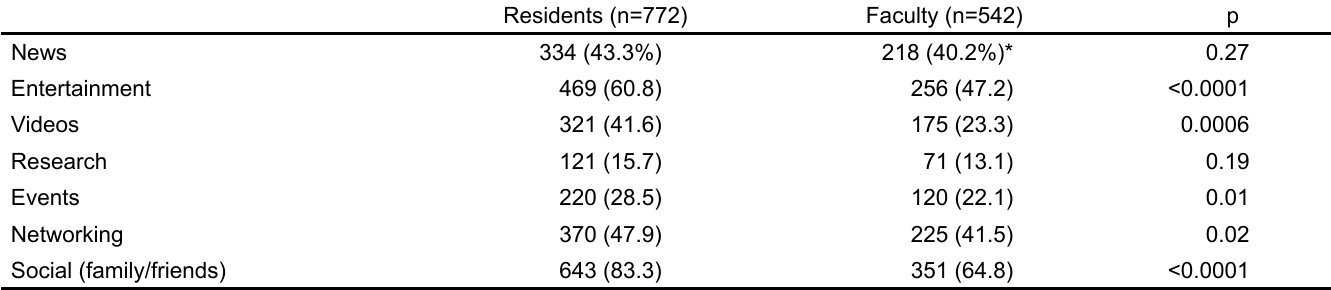
Table 3. Reasons for personal use of social media.